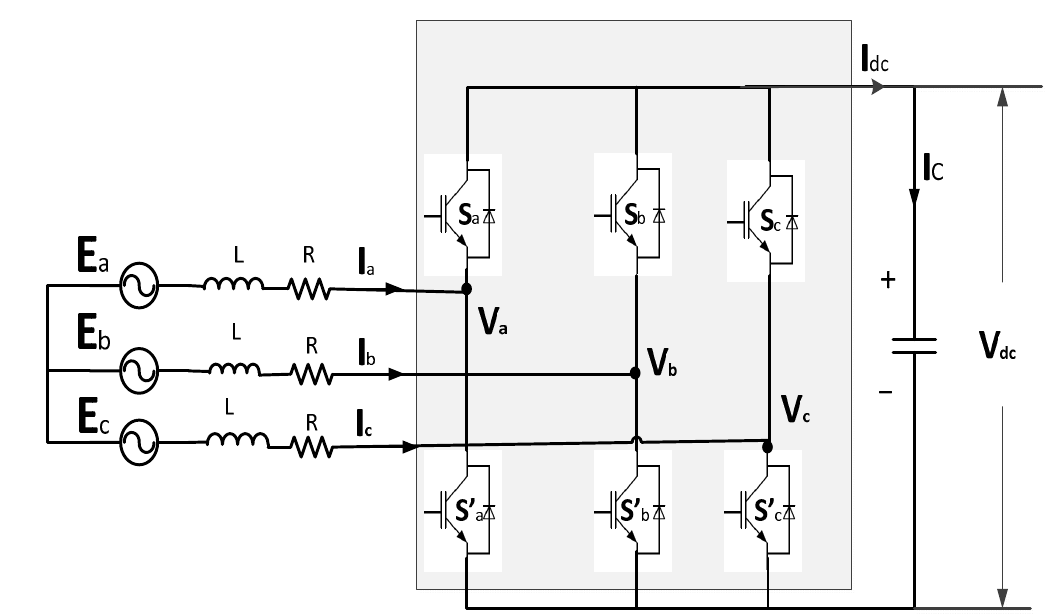
Figure 10. A schematic diagram of the inverter connected with the grid.